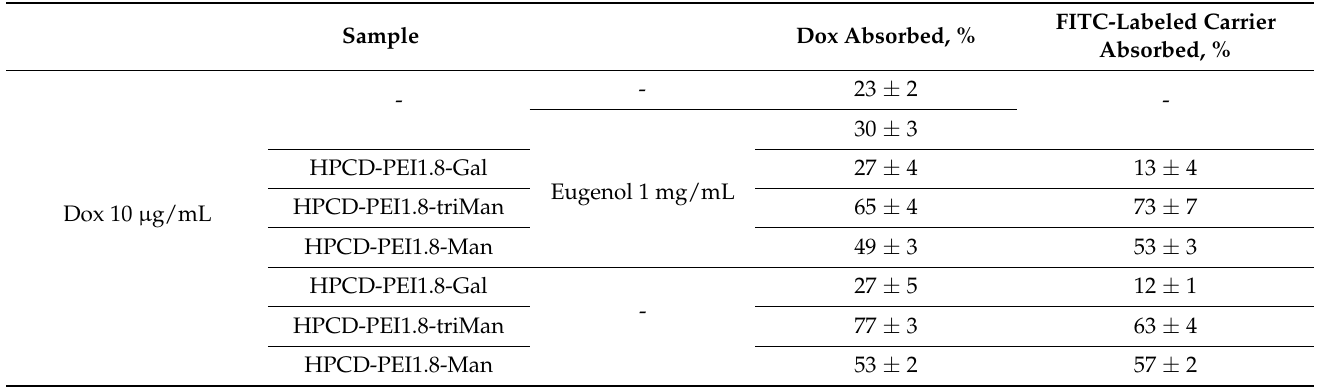
Table 2. The amounts of Dox and FITC-labeled carrier absorbed by macrophages with E. coli inside. Fluorescence detection (Method section). T = 22 ◦